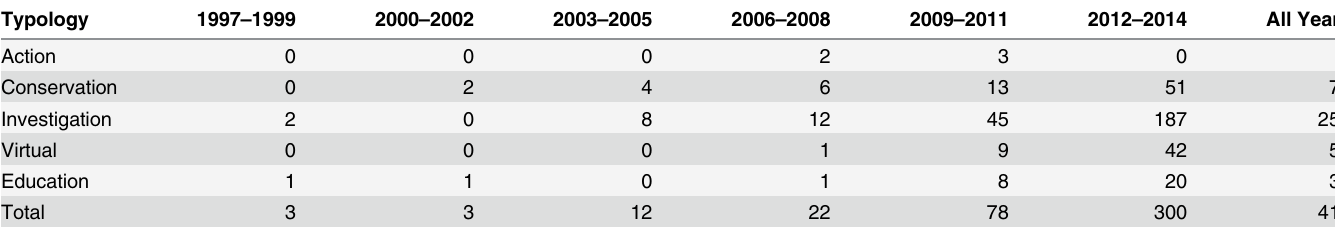
Table 2. The number of articles on citizen science projects broken into their typologies groups from 1997 to 2014.